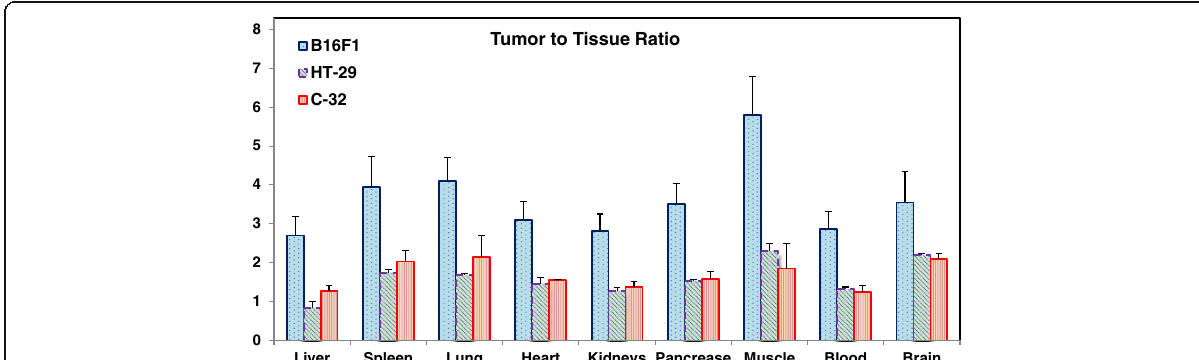
Fig. 6 Tumor-to-normal tissue ratio at 1 h is presented for the mice bearing B16F1, C-32, and HT-29 tumors. The tumor-to-tissue ratio for the amelanotic C-32 and colorectal adenocarcinoma HT-29 group of mice were quite similar and these ratios were appreciably lower than that for the mice from B16F1 group. A twofold lower tumor-to-muscle ratio was noted for the C-32 and HT-29 as compared to that from B16F1